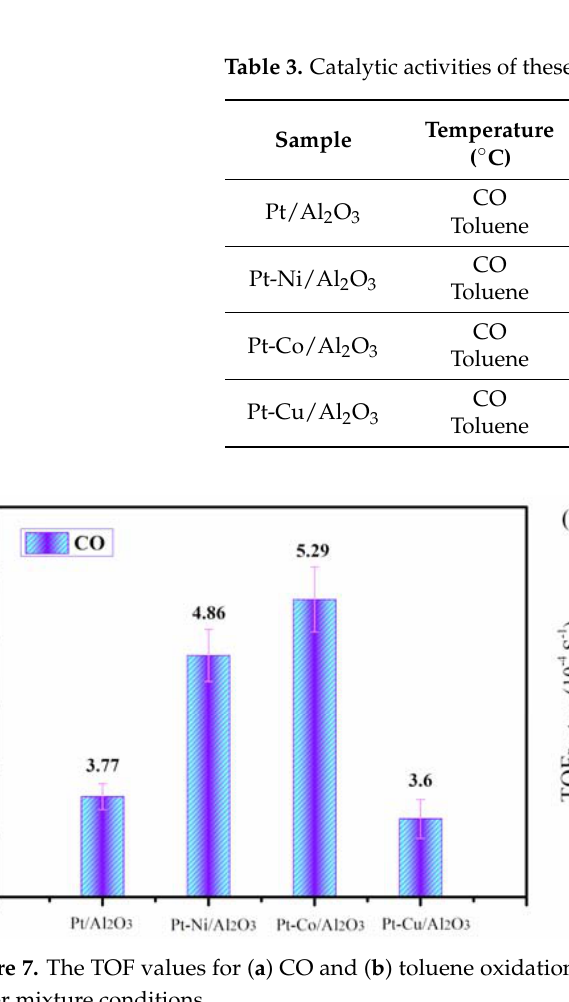
Figure 7. The TOF values for ( a ) CO and ( b ) toluene oxidation over these Pt/Al 2 O 3 and Pt-M/Al 2 O 3 samples at 190 ◦ C under mixture conditions.